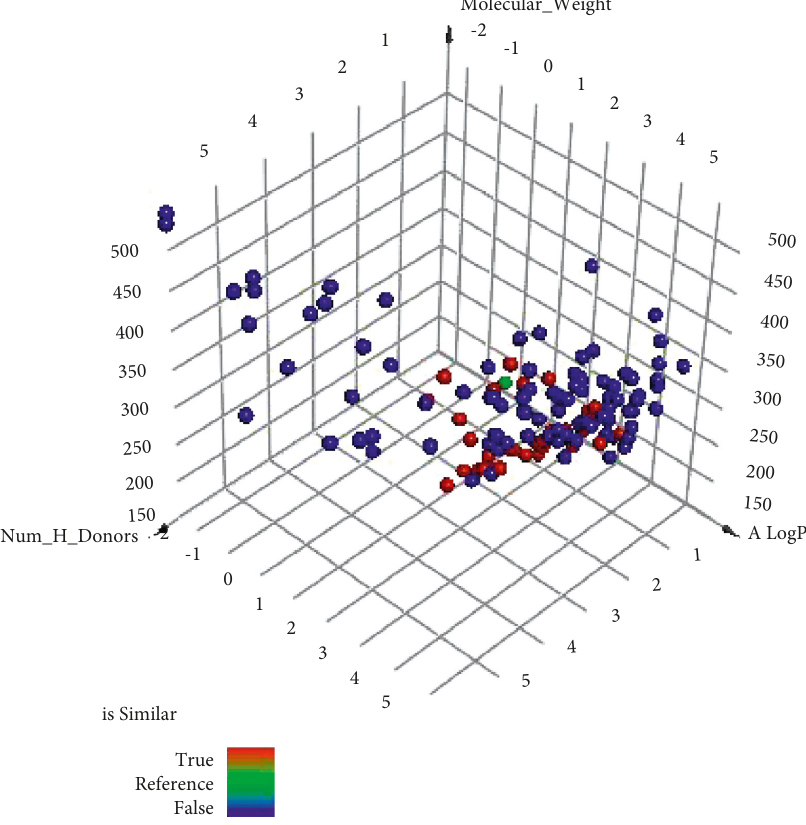
Figure 2: Molecular similarity of the examined compounds and VXG